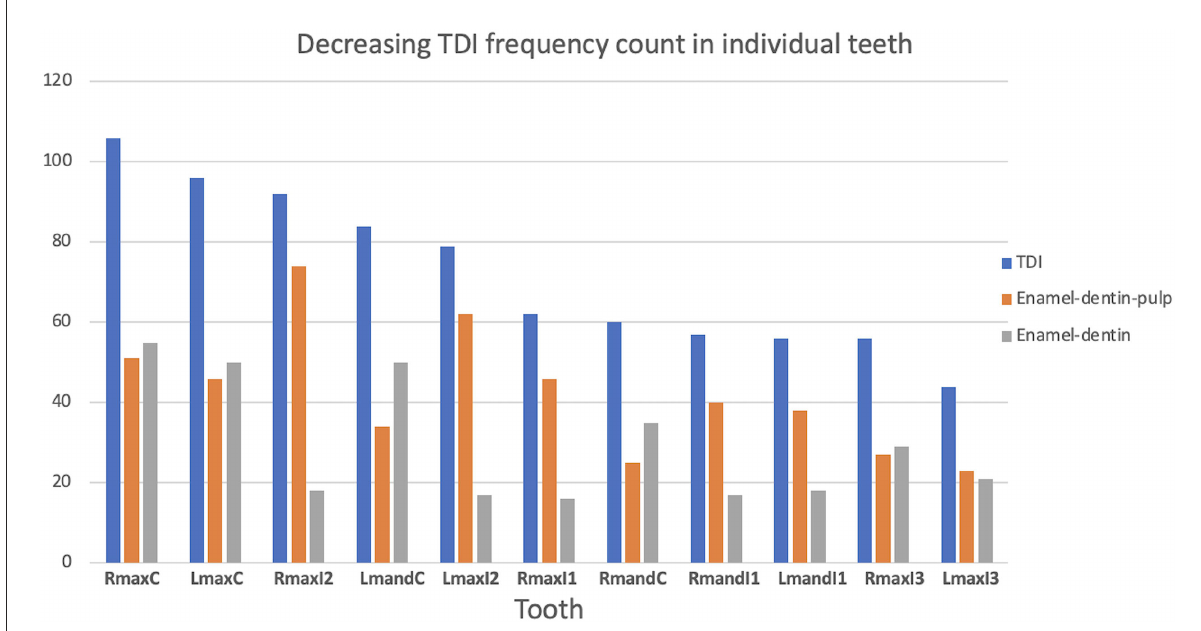
FIGURE4 Graphical description of the decreasing frequency of TDI and the occurrence of enamel-dentin-pulp fractures and enamel-dentin fractures in individual teeth.